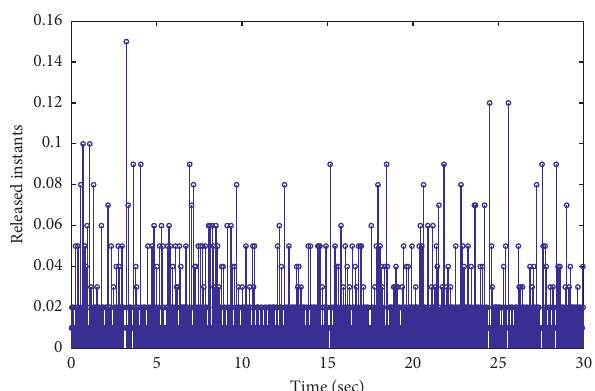
Figure 6: Transmit time and transmit interval for case-II.